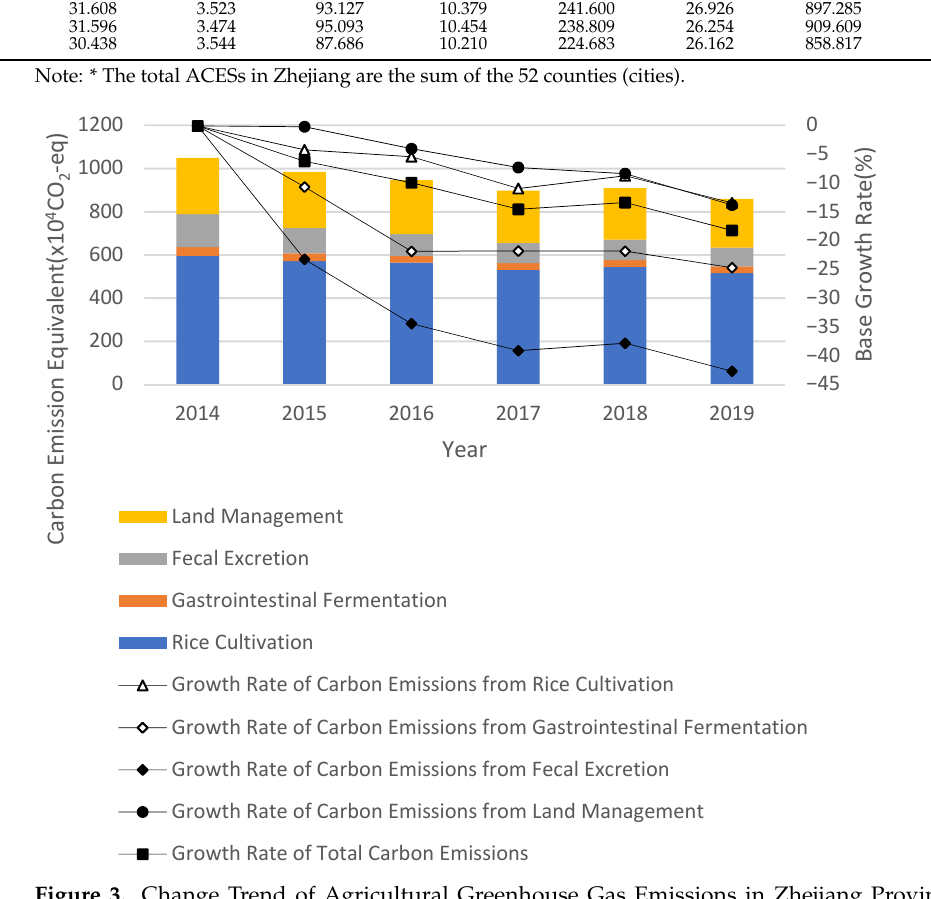
Table 4. Structure and Intensity of Agricultural Greenhouse Gas Emissions and Total Agricultural Greenhouse Gas Emissions in Zhejiang Province from 2014 to 2019.